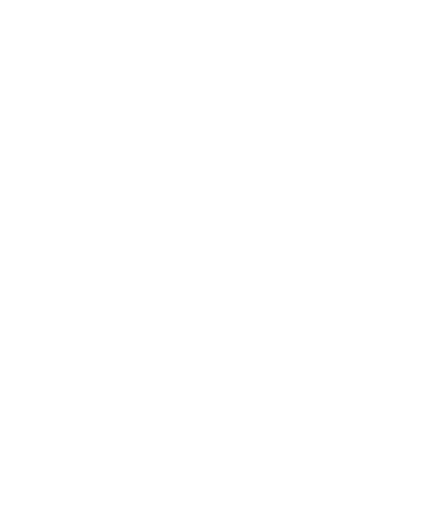
Table 1. Specifications for laser